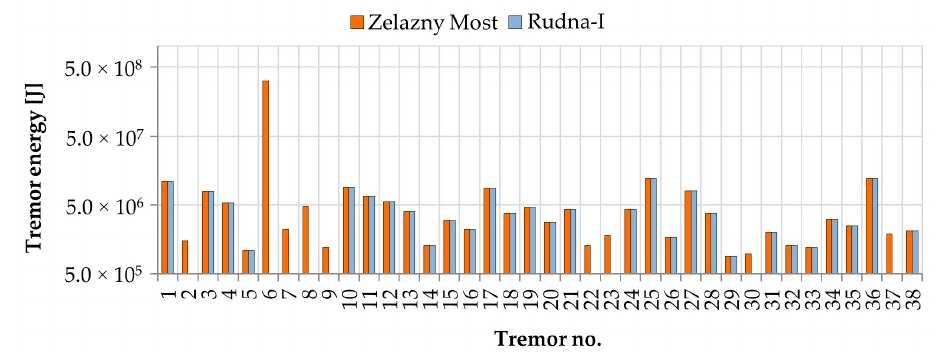
Figure 5. The energy of mining tremors recorder at a distance < 8 km.